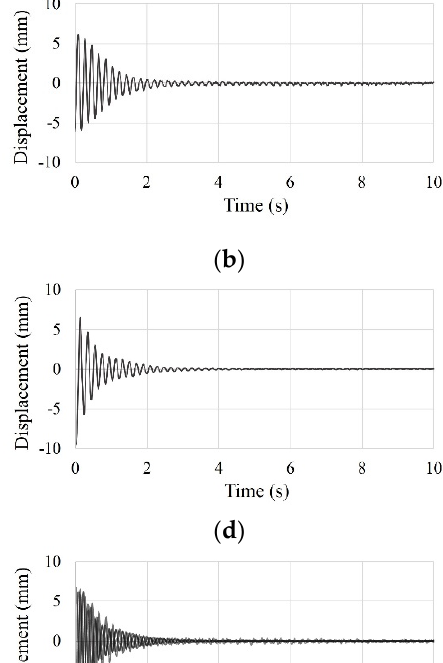
Figure 9. Example of time history curve of the free vibration.